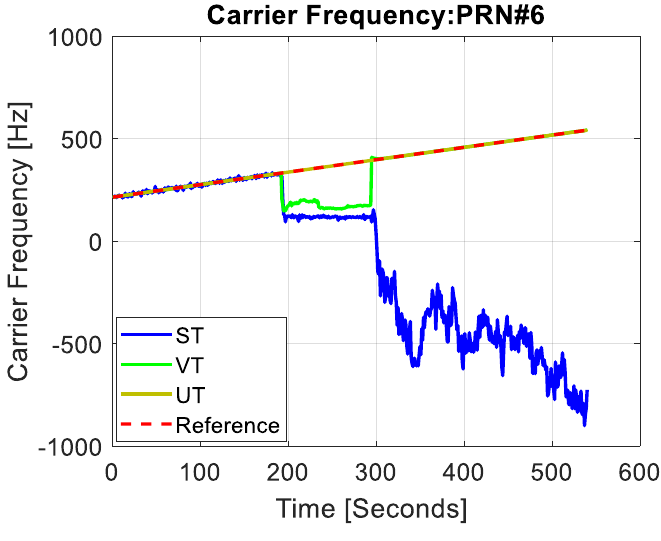
Figure 13. Carrier Frequency PRN6.